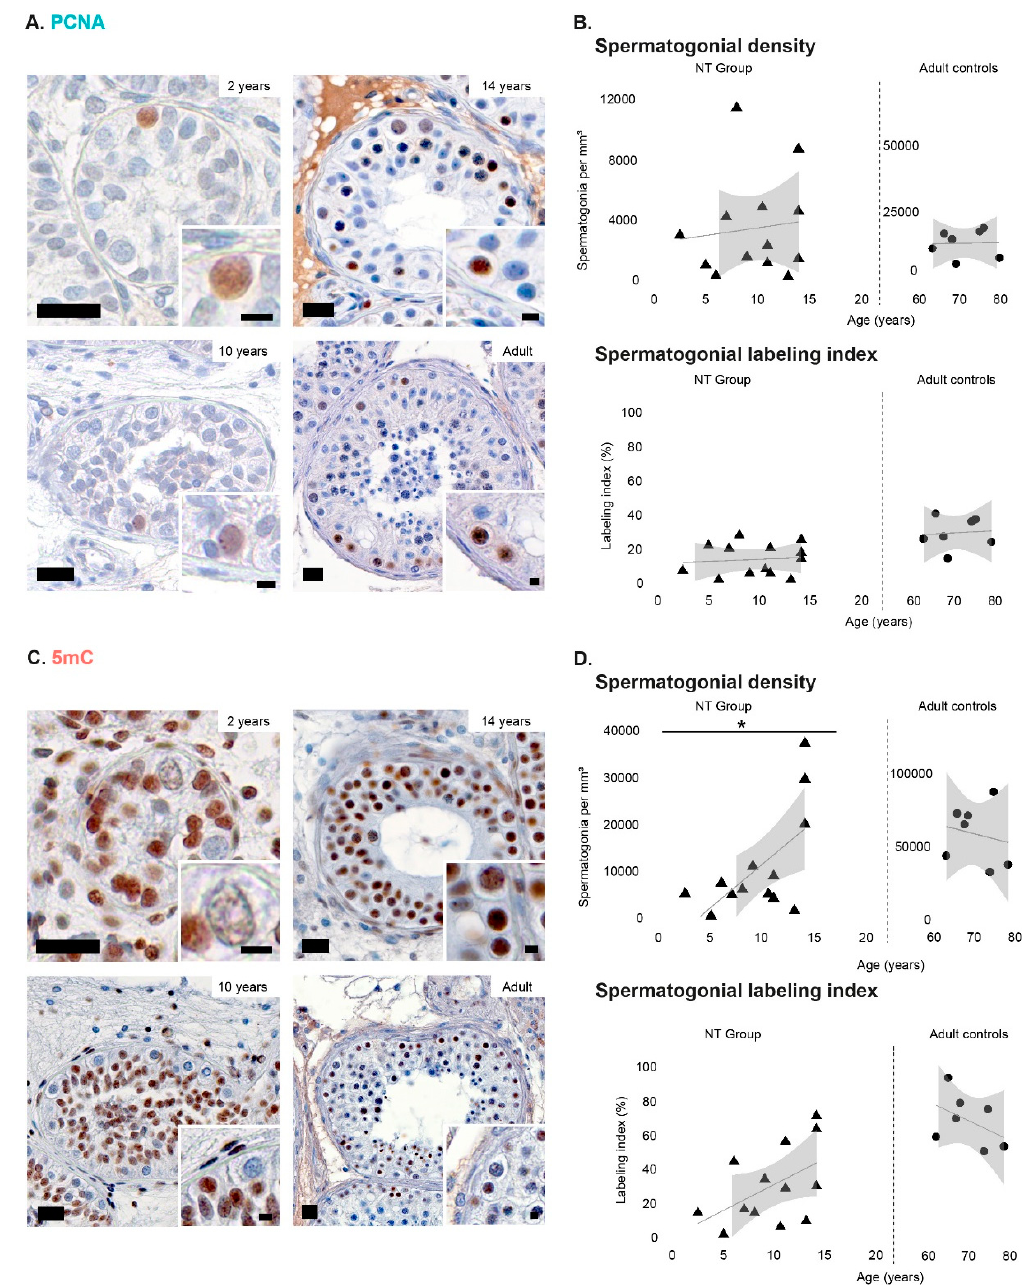
Figure 2. Spermatogonial expression of PCNA and 5mC throughout age. ( A ) Immunohistochemical identification of PCNA-positive (brown) spermatogonia at several testicular developmental stages. Scale bar: 20 µm. ( B ) Density and labeling index (%) of PCNA-positive spermatogonia during normal development (NT group) and adulthood. ( C ) Immunohistochemical identification of 5mC-positive (brown) spermatogonia at several testicular developmental stages. Scale bar: 20 µm. ( D ) Density and labeling index (%) of 5mC-positive spermatogonia during normal development (NT group) and adulthood. Individual values, trend line, and 95% confidence interval are represented. Generalized linear models were used to predict the response of labeling index based on the patients’ age. Statistically significant difference is represented as * p < 0.05.